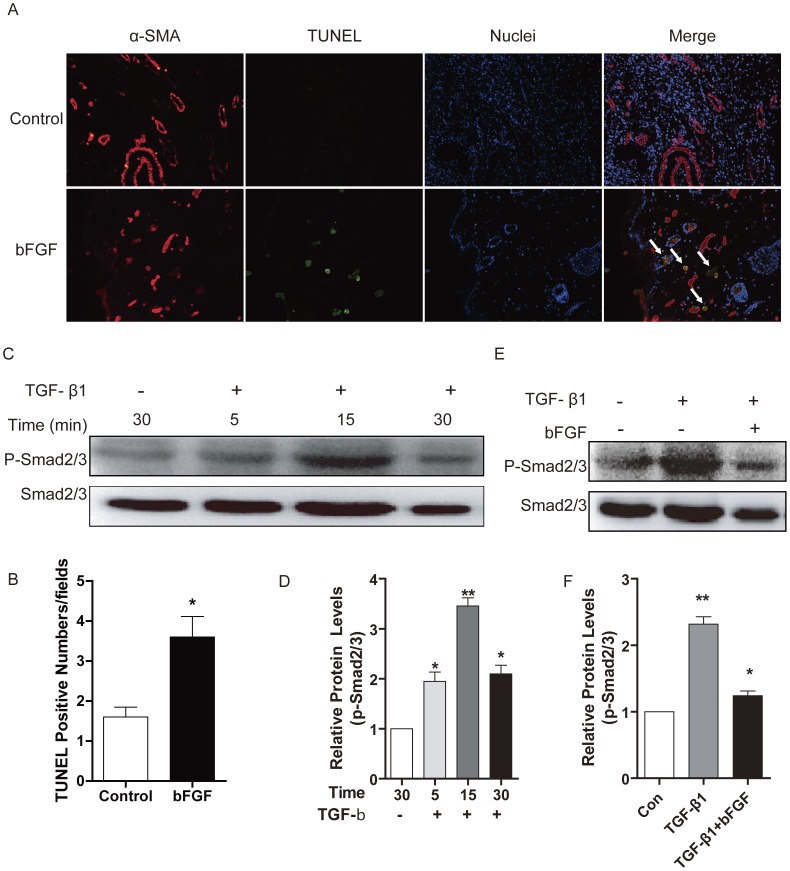
bFGF induced cells apoptosis and inhibited TGF-β1/SMAD signaling pathway.(A and B) TUNEL staining analysis of the apoptosis cells in rat skin by bFGF or saline in day 14 after wounding. The nuclear was labeled by Hoechst (blue), the myofibroblast was labeled by α-SMA (red), the apoptosis cells was labeled by TUNEL (green). Colocalization of α-SMA and TUNEL indicate apoptosis myofibroblast (white arrow) (×200). *P<0.05 compared to control. (C and D) Western blot analysis of the phosphorylation of SMAD2/3 (Ser 423/425) in HSF incubated with TGF-β1 (5 ng/ml). (E and F) Western blot analysis of the phosphorylation of SMAD2/3 in HSF incubated with TGF-β1 and bFGF (10 ng/ml). *P<0.05, **P<0.01 compared to control group.